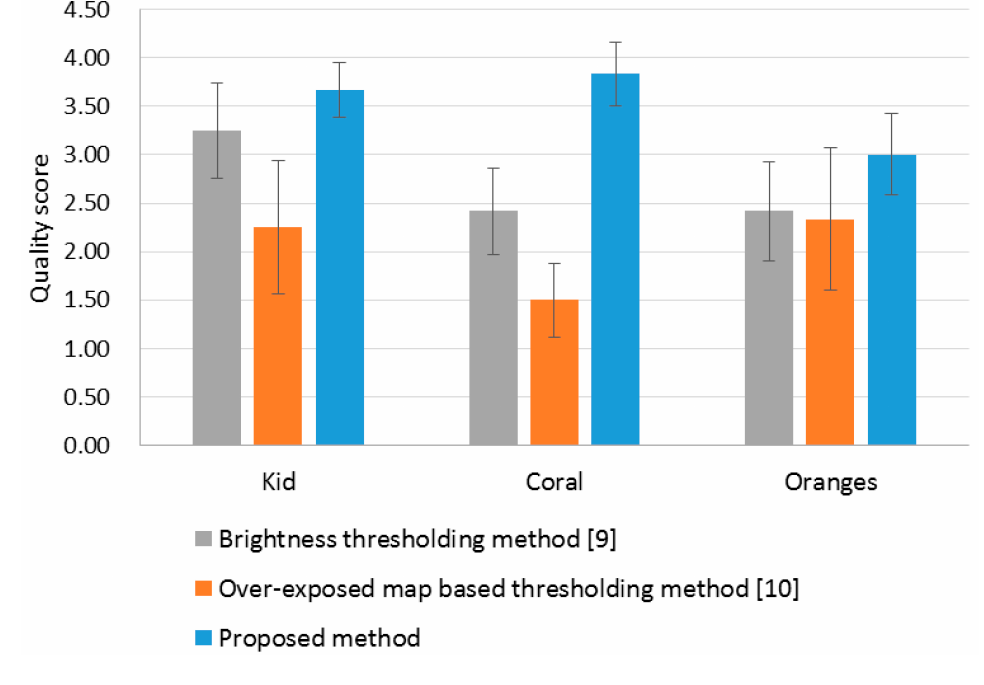
Figure 8. Subjective evaluation result for the over-exposure correction